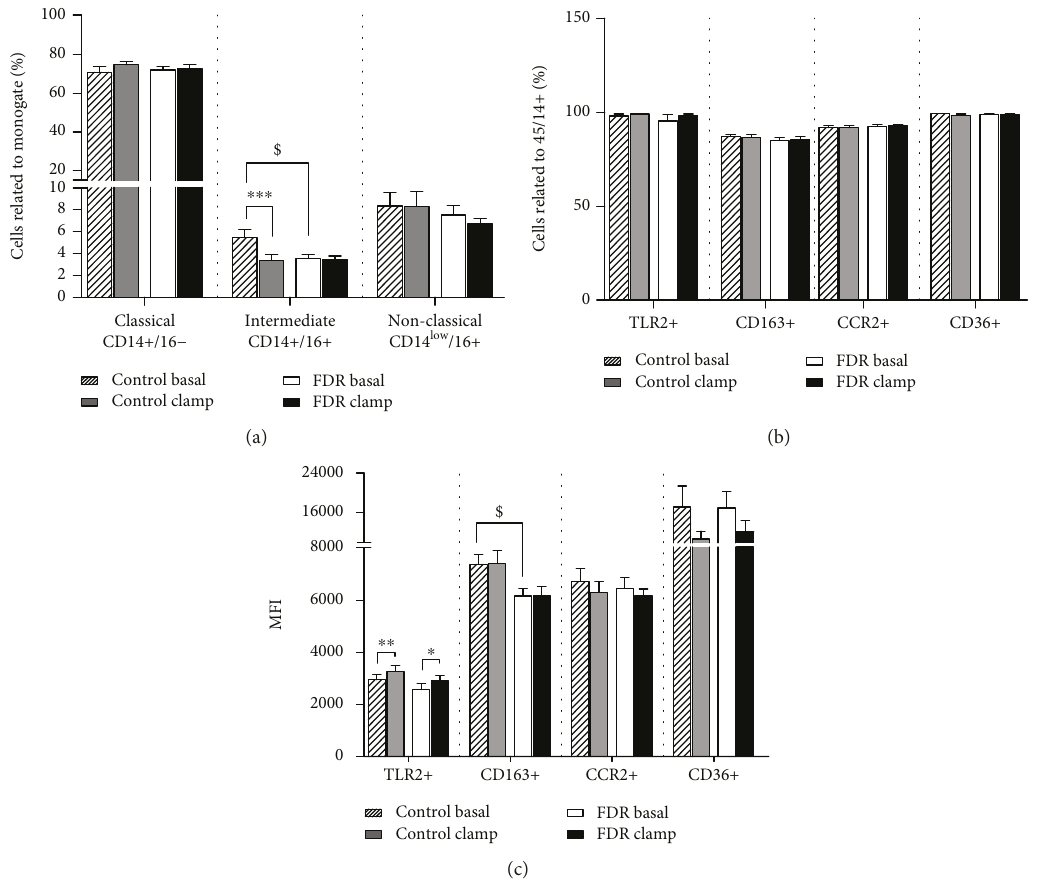
Figure 2: E ff ect of hyperinsulinemia on monocyte populations in the blood in FDR and in control subjects: (a) classical, intermediate, and nonclassical monocytes expressed as the percentage of positive cells related to CD45/14+; (b) monocyte populations expressing markers TLR2, CD163, CCR2, and CD36 expressed as the percentage of positive cells related to CD45/14+; (c) expression of markers TLR2, CD163, CCR2, and CD36 on monocyte subsets expressed as MFI ∗∗ p < 0 01 ; ∗ p < 0 05 , signi fi cant change during the euglycemic- hyperinsulinemic clamp; $ p < 0 05 , signi fi cant di ff erence between FDR and control subjects at baseline; striped bars — baseline preclamp levels in controls; grey bars — postclamp levels at the end (2 hours) of the clamp in controls; white bars — baseline preclamp levels in FDR; black bars — postclamp levels at the end (2 hours) of the clamp in FDR. FDR: fi rst-degree relatives; MFI: mean fl uorescence intensity.